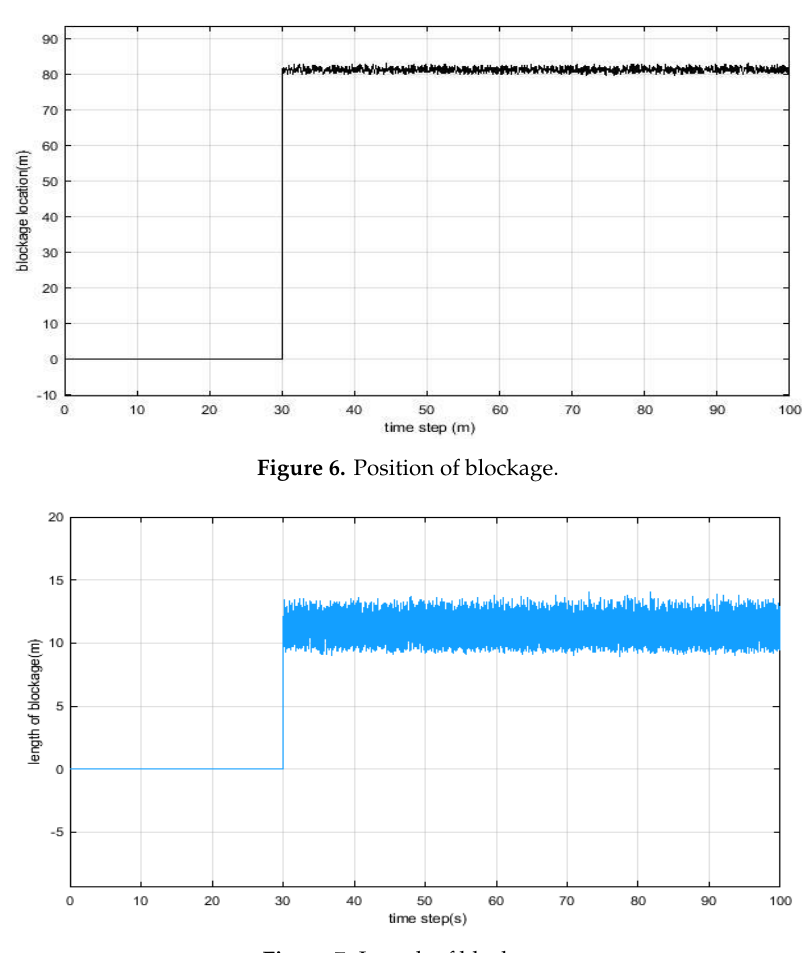
Figure 7. Length of blockage.